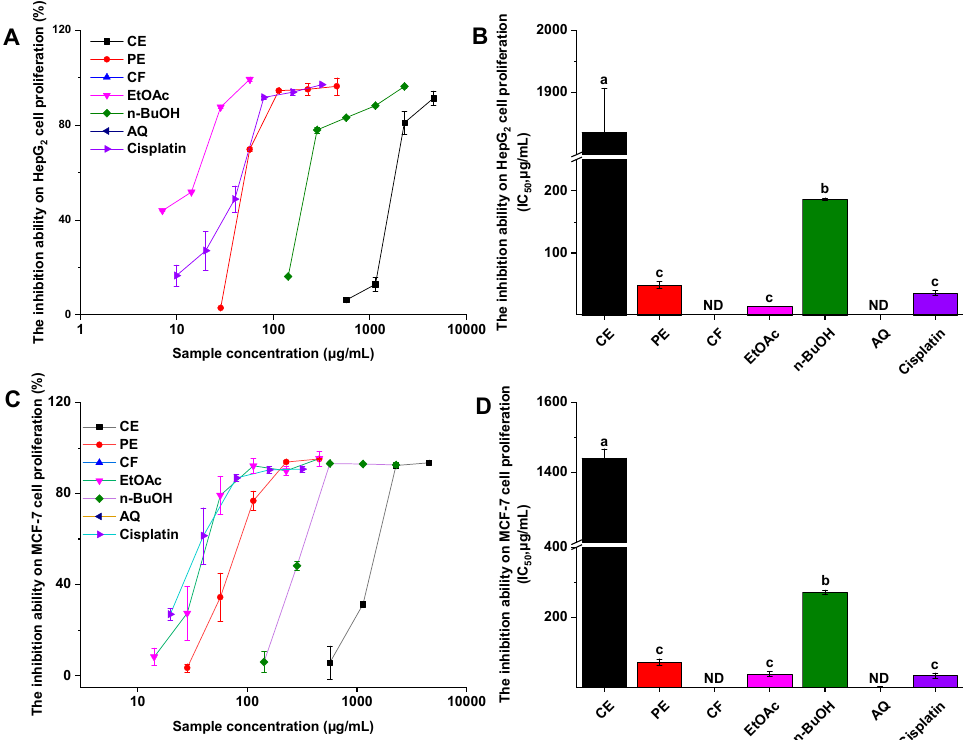
Figure 4. The cell proliferation inhibitory activity of the P. frutescens leave extract and its fractions. ( A ) The inhibition ratio of HepG2 cell proliferation incubated with different concentrations of samples; ( B ) the IC 50 values of different samples for HepG2 cell proliferation inhibition; ( C ) the inhibition ratio of MCF-7 cell proliferation incubated with different concentrations of samples; ( D ) the IC 50 values of different samples for MCF-7 cell proliferation inhibition. ND = not detected; CE = crude extract; PE = petroleum ether fraction; CF = chloroform fraction; EtOAc = ethyl acetate fraction; n-BuOH = n-butanol fraction; AQ = aqueous phase residue. Bars with different letters indicate a significant difference ( p < 0.05).